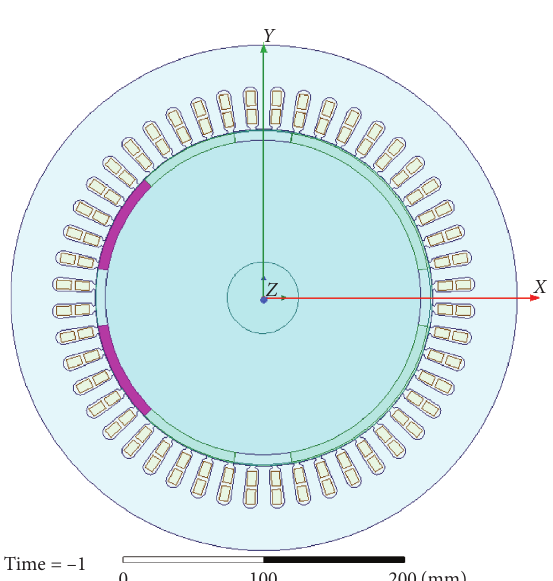
Figure 3: The diagram of UMP trend under the change of air-gap MMF.